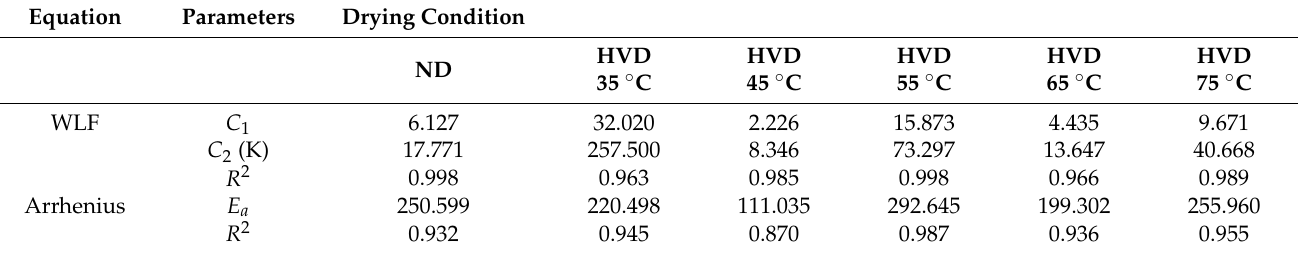
Table 4. WLF constants and Arrhenius activation energy for maize kernels